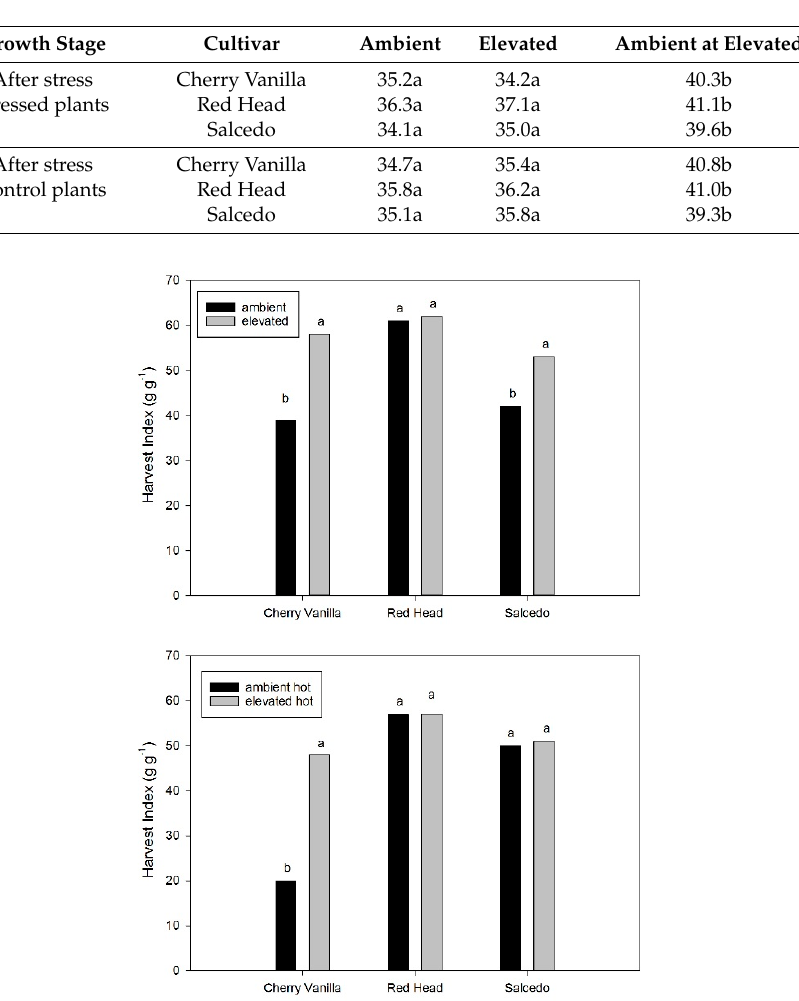
Figure 2. Harvest index (seed dry mass/total aboveground dry mass) at final harvest for three cultivars of quinoa grown at ambient (400 μ mol·mol − 1 ) or elevated (600 μ mol·mol − 1 ) CO 2 concentrations, with or without a high temperature treatment for 7 days beginning at anthesis. The control growth day/night temperatures were 20/14 °C, and the high temperature treatment was 35/29 °C. Within cultivars and temperature treatments, different letters indicate significant differences in mean values, based on